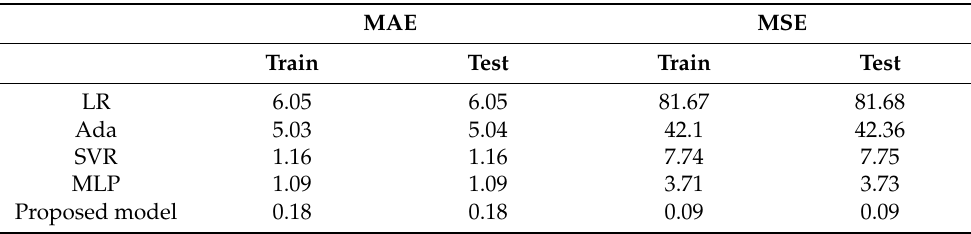
Table 4. Results of average 10-fold cross-validation for the benchmarks and the proposed model.